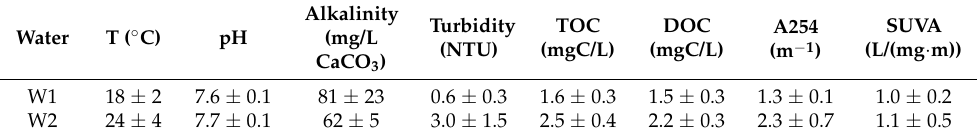
Table 1. Characteristics of PAC/coagulation/MF pilot intake waters (average ± standard